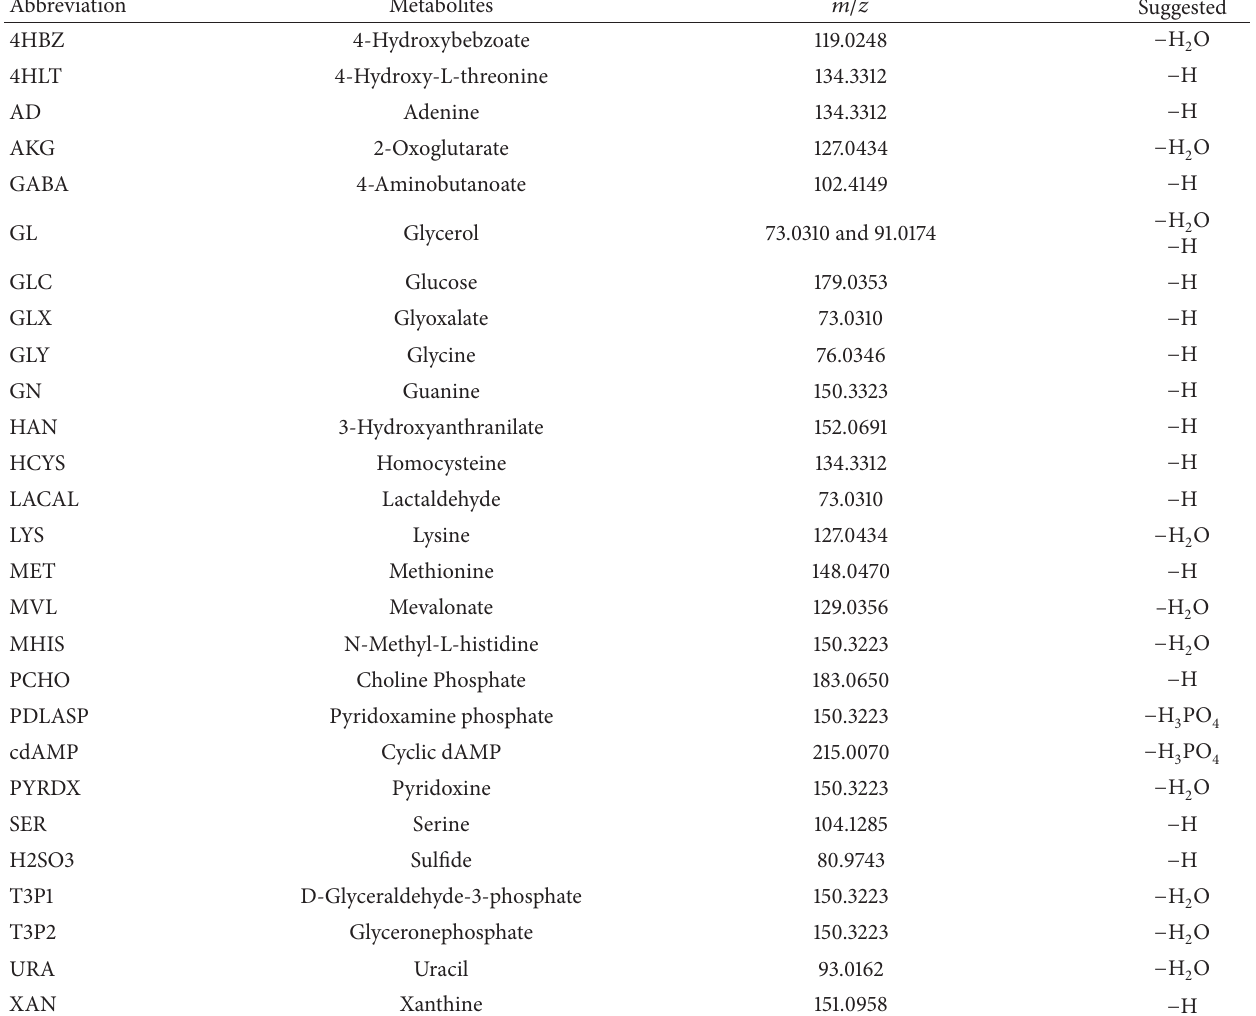
Table 6: List of key metabolites in negative ESI